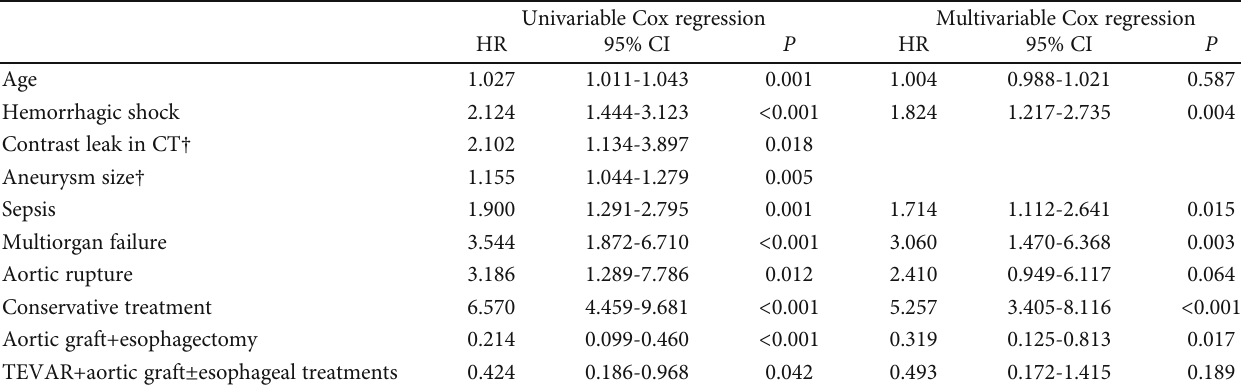
Table 5: Cox regression